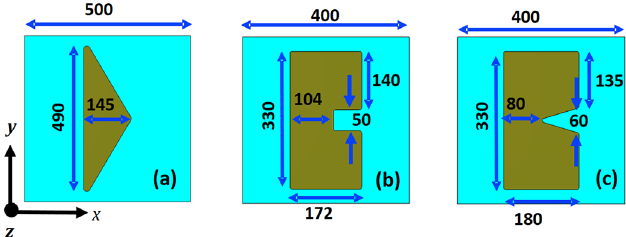
Fig. 2. Unit cell structures of metaatoms discussed in this work: (a) Triangle, (b) SRR, and (c) Heptagon. Size parameters are in nm. The size parameters de fi ne the structure before rounding the corners with radius of 10